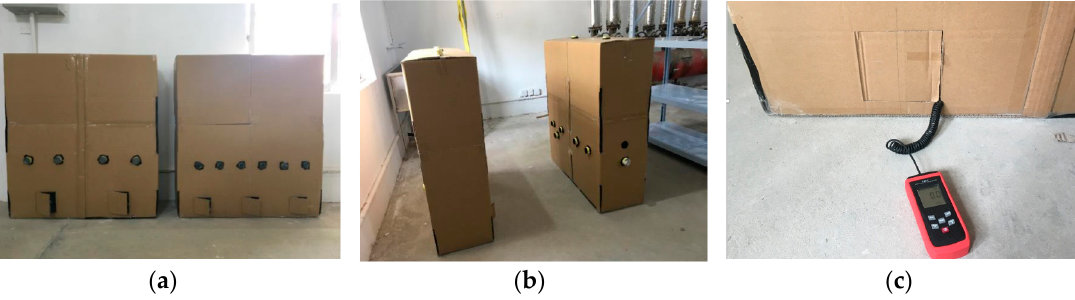
Figure 7. The experimental setup of the SOGL system: ( a ) back view, ( b ) side view and ( c ) the ground floor room and the digital illuminometer. Table 6. The measured and modified illumination intensity of the SOGL system in the experimental study at different times in the day and their relative errors to the simulated results ( α =